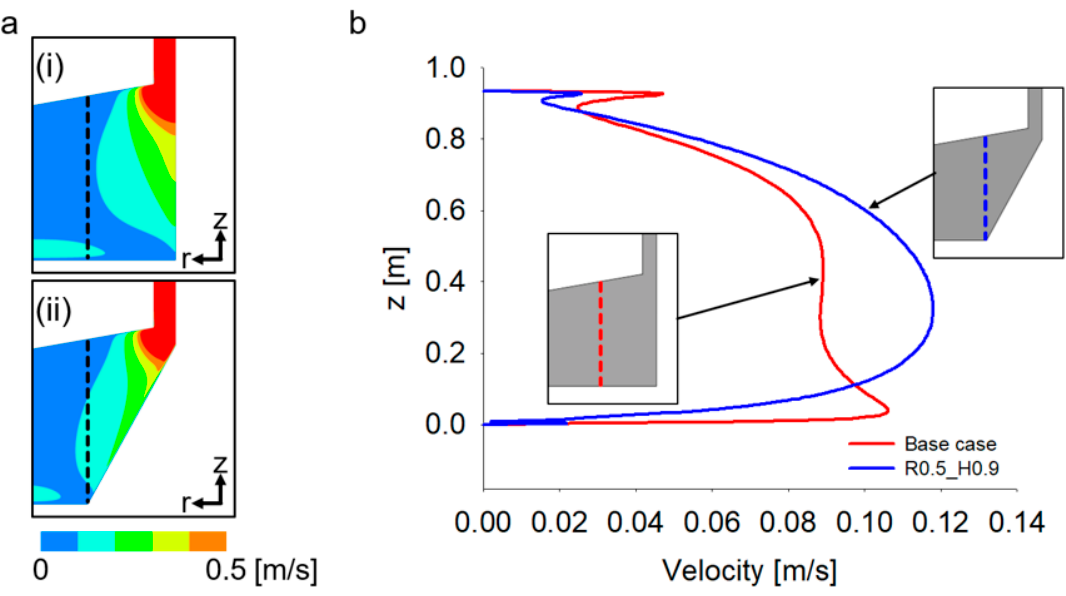
Figure 4. Comparison of the velocity at the center of the collector. ( a ) Velocity contours of the ( i ) base case and ( ii ) R0.5_H0.9. ( b ) Velocity profiles along the red lines indicated in the insets.